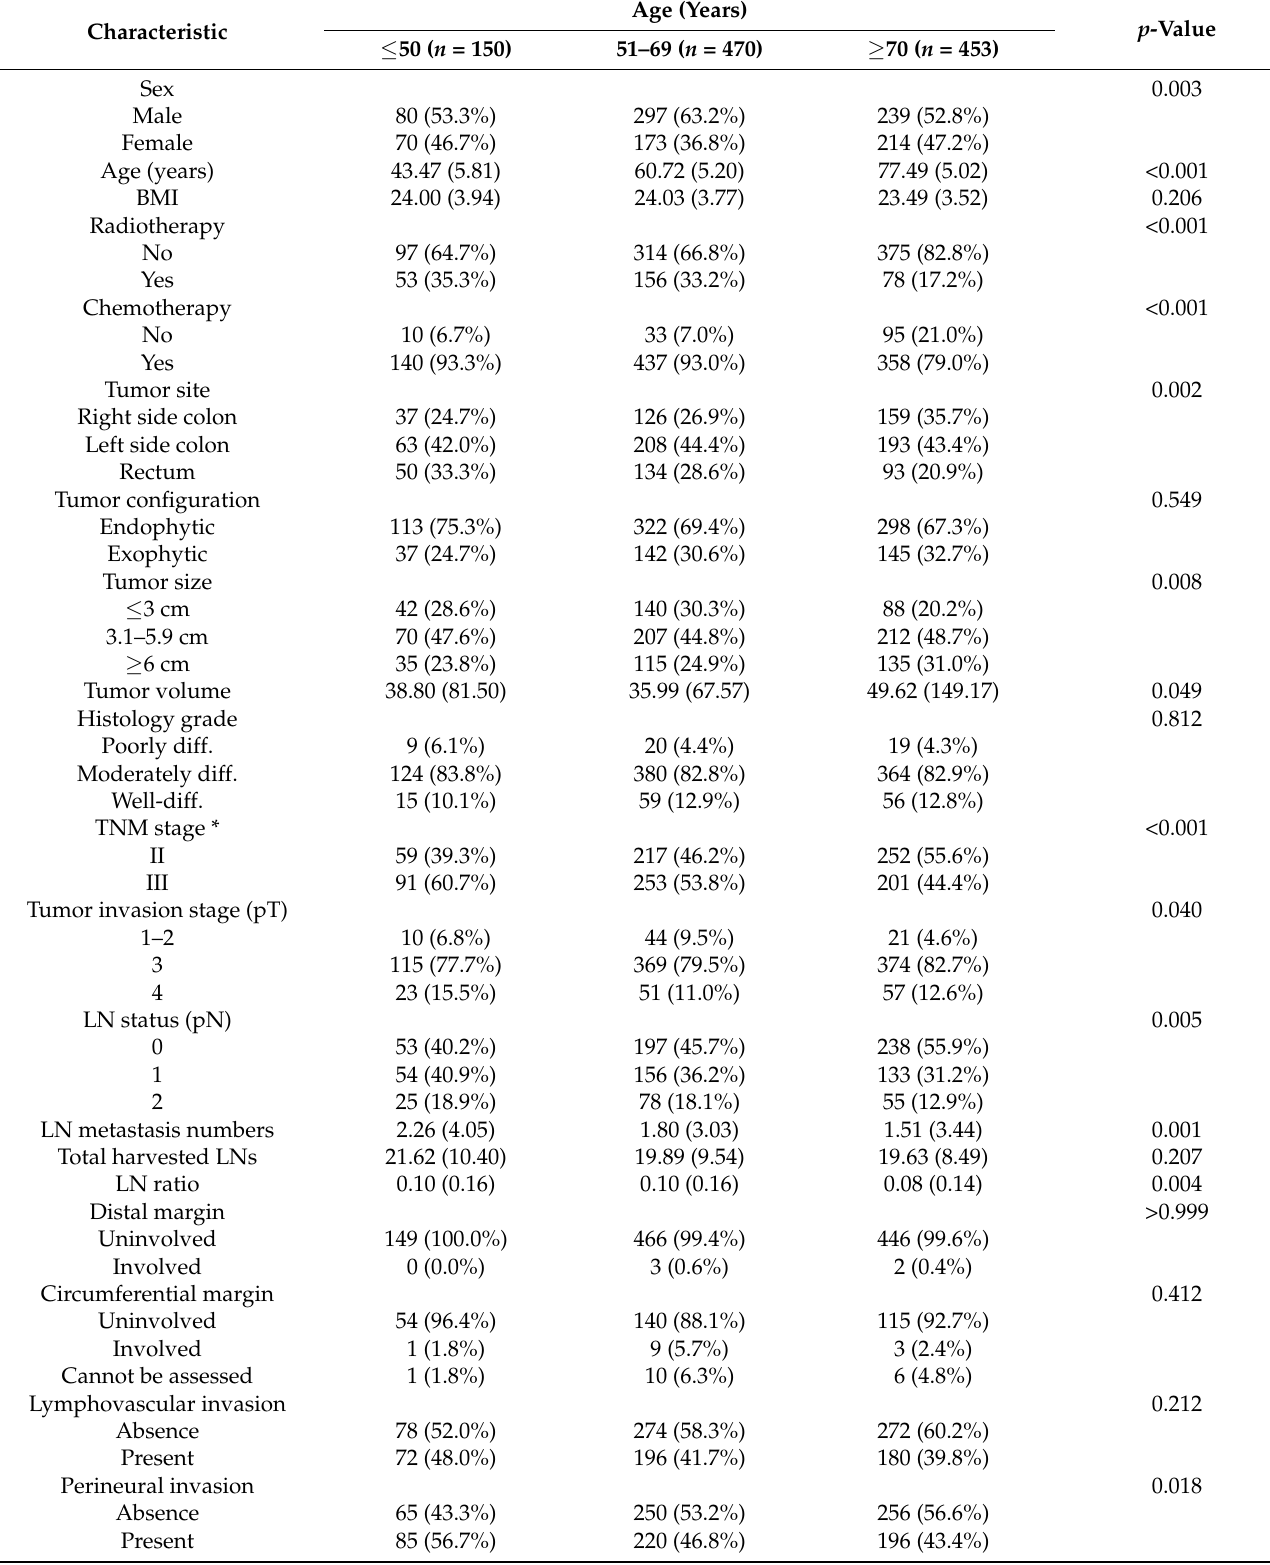
Table 4. Characteristics of patients with stage II and III colorectal